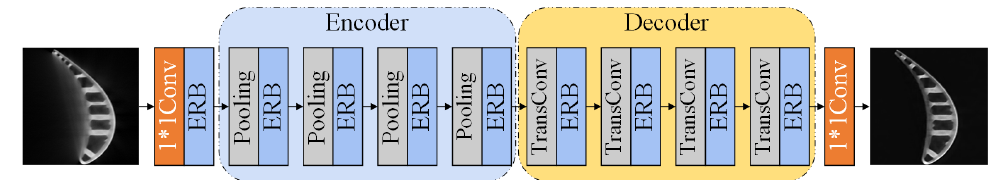
Figure 8. The structure of the Encoder–Decoder model for turbine blade ICT images artifact